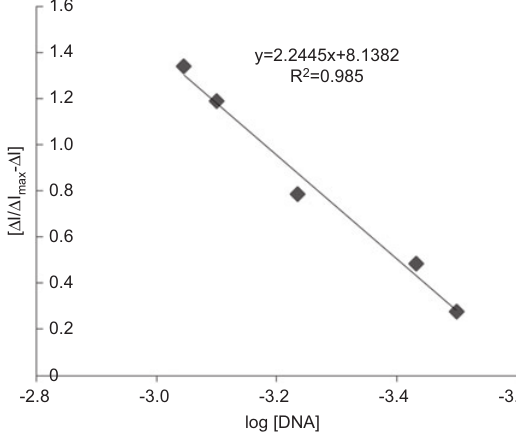
Figure 9 The relationship between [ Δ I/ Δ I - Δ I] and log [DNA] max on multi-walled carbon nanotube paste electrode (MWCNTPE) in 0.2 m acetate buffer solution (pH 5.0 ± 0.01) in the absence and pres- ence of DNA, respectively.